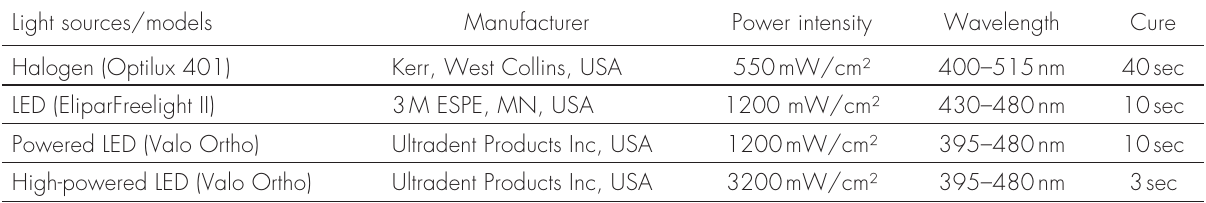
Table I. Technical details about light